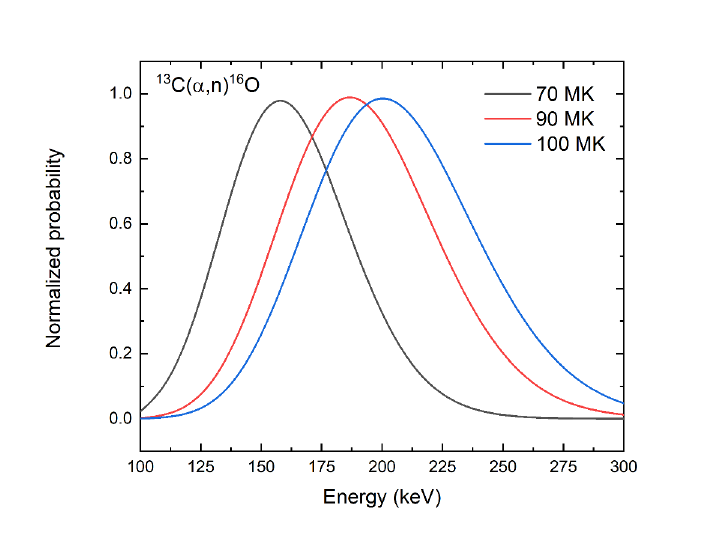
Figure 1. Maxwell-Boltzmann distribution versus energy E for the 13 C( α , n) 16 O reaction at three dif- ferent temperature